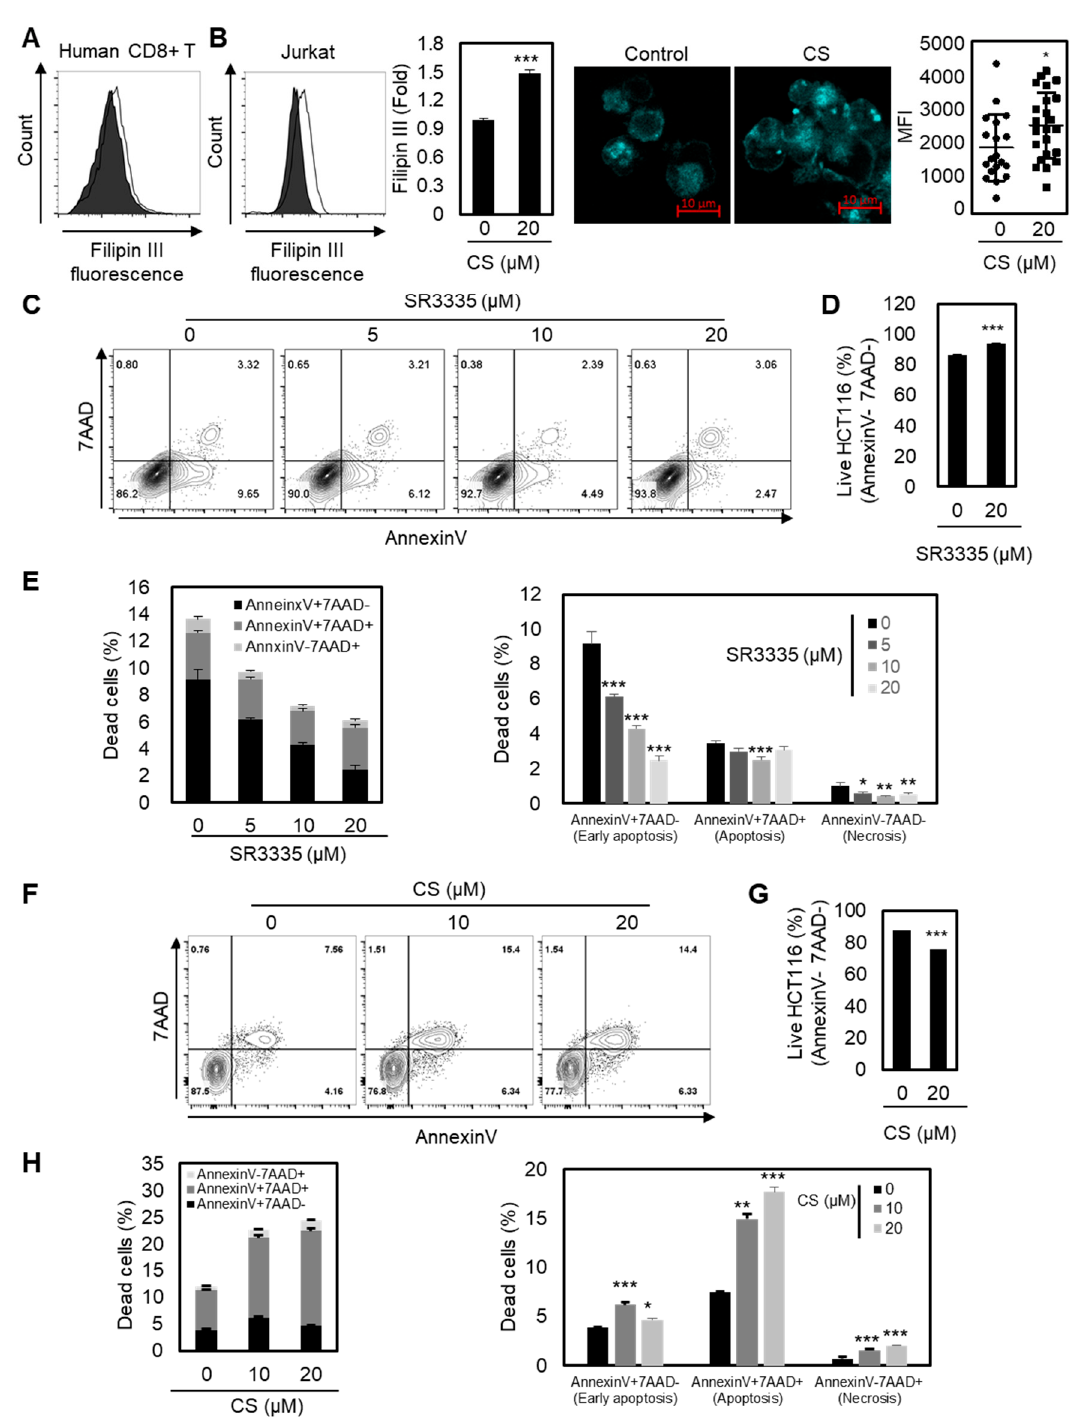
Figure 4. Enhanced cholesterol level by ROR α may potentiate the antitumor activity of CD8 + T cells. ( A , B ) Cholesterol quantification of CD8 + T cells ( A ) or Jurkat ( B ) cells by Filipin III staining. CD8 + T cells or Jurkat cells were activated in the presence of CS 20 µ M. The p -value was calculated by a t -test (*** p < 0.001). ( C , D , and E ) Quantification of cell death in colon cancer. HCT116 cells were cocultured with CD8 + T cells pretreated with SR3335 for three days. The p -value was calculated by a t -test (* p < 0.05, ** p < 0.01, *** p < 0.001). ( F – H ) Quantification of cell death in cancer. HCT116 cells were cocultured with CD8 + T cells pretreated with CS for three days. The p -value was calculated by a t -test (* p < 0.05, ** p < 0.01, *** p < 0.001).